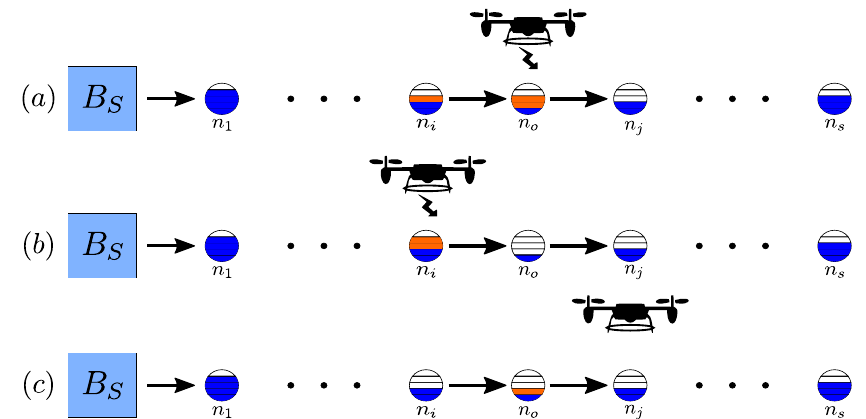
Figure 1. An unmanned aerial vehicle (UAV) charging a wireless rechargeable sensor network (WRSN) based on the stopping point: ( a ) optimal stopping point, ( b ) early stopping, ( c ) late stopping. Blue indicates power level of sensor node, orange added power by wireless